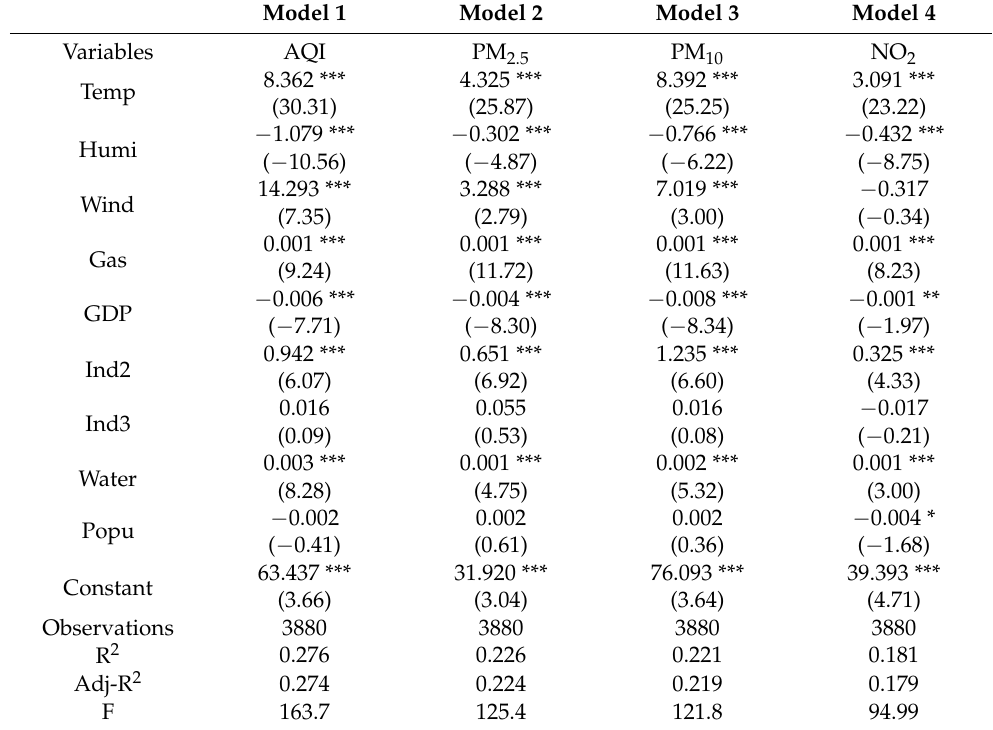
Table 4. Variable regression results